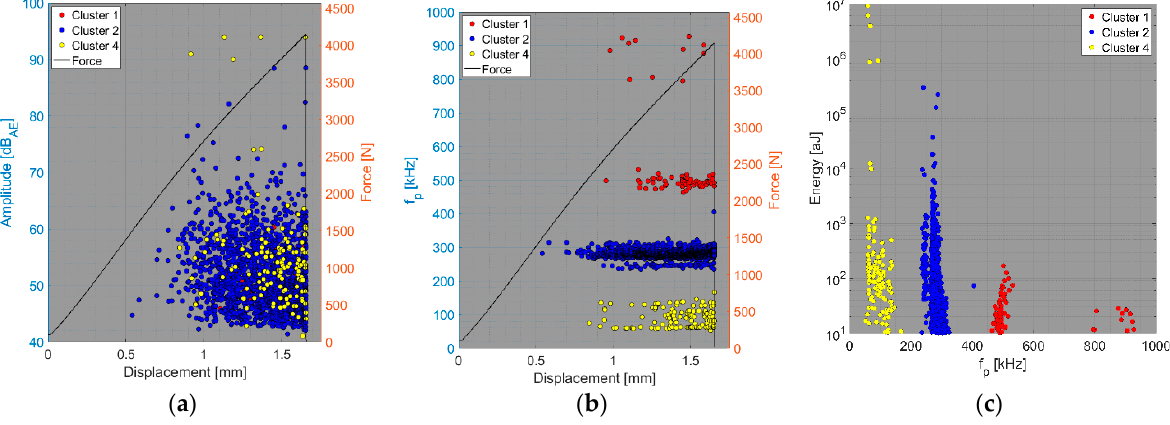
Figure 20. Clustering results for a CPT representative sample using a spectral clustering algorithm and secondary filtering using a partial power variable (Fujicera 1045S dataset).